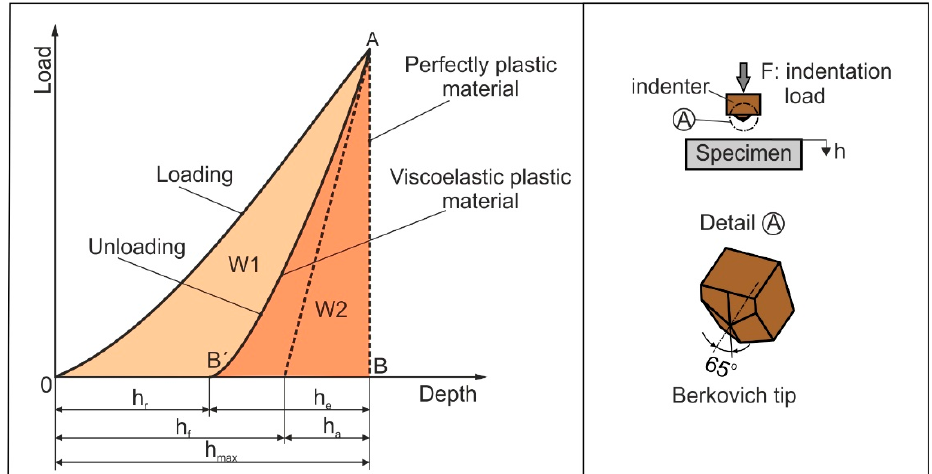
Figure 2. Schematic of a typical nanoindentation load-depth curve of a viscoelastic-plastic material where h max : the maximum depth, h e : the elastic depth rebound, h r : the residual impression depth, h a : the displacement of the surface at the perimeter, and h f : the contact indentation depth.